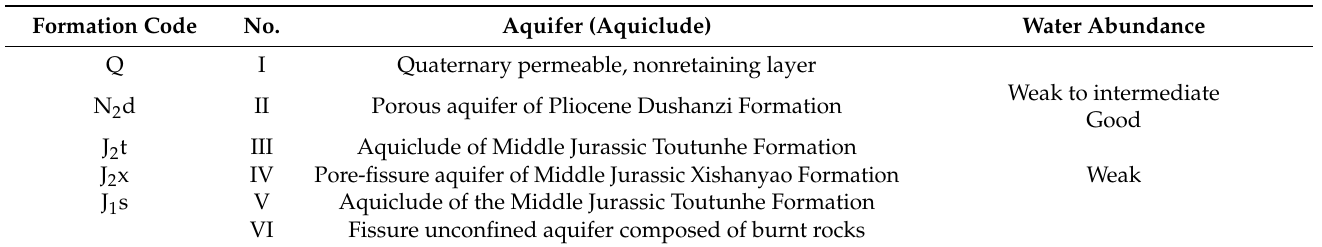
Table 1. Division of aquifers (aquicludes).